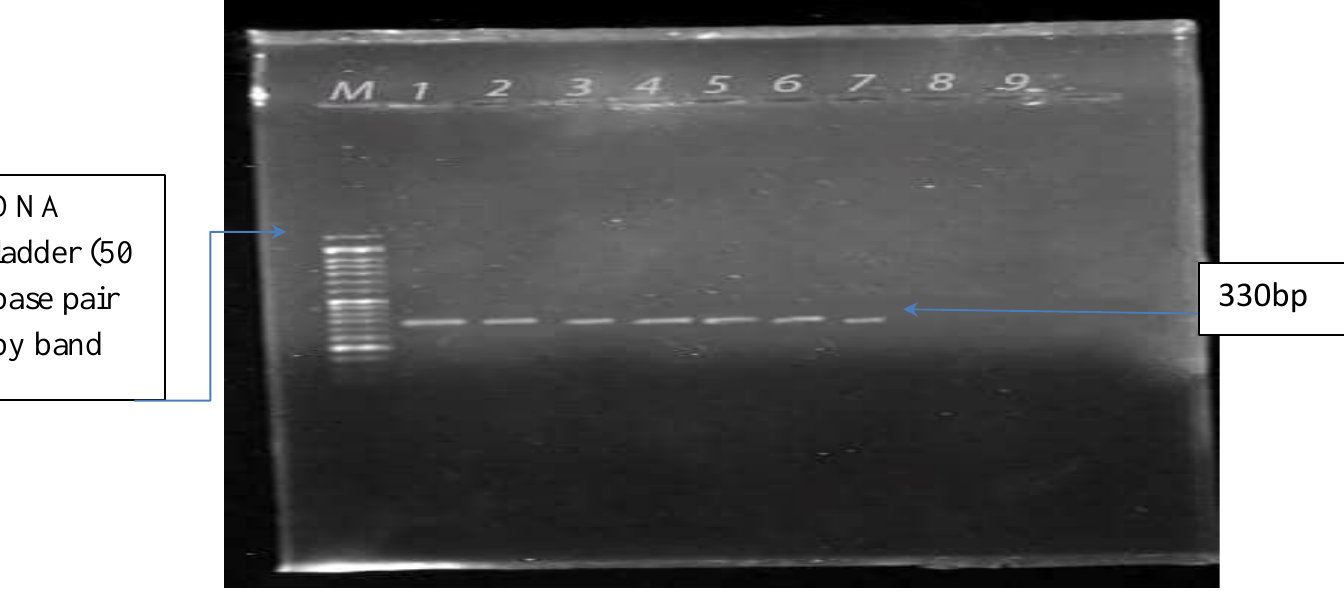
Figure 1. Gel electrophoresis of the PCR amplified products for the detection of 16s rRNA of Pantoea spp. lane M is a DNA marker 50 base pair by a band, lanes 2 to7 are represented to positive isolates of 16s rRNA gene (330bp), lane 1 is positive control obtained from the Department of Clinical Pathology Assiut university and lane 9 is negative